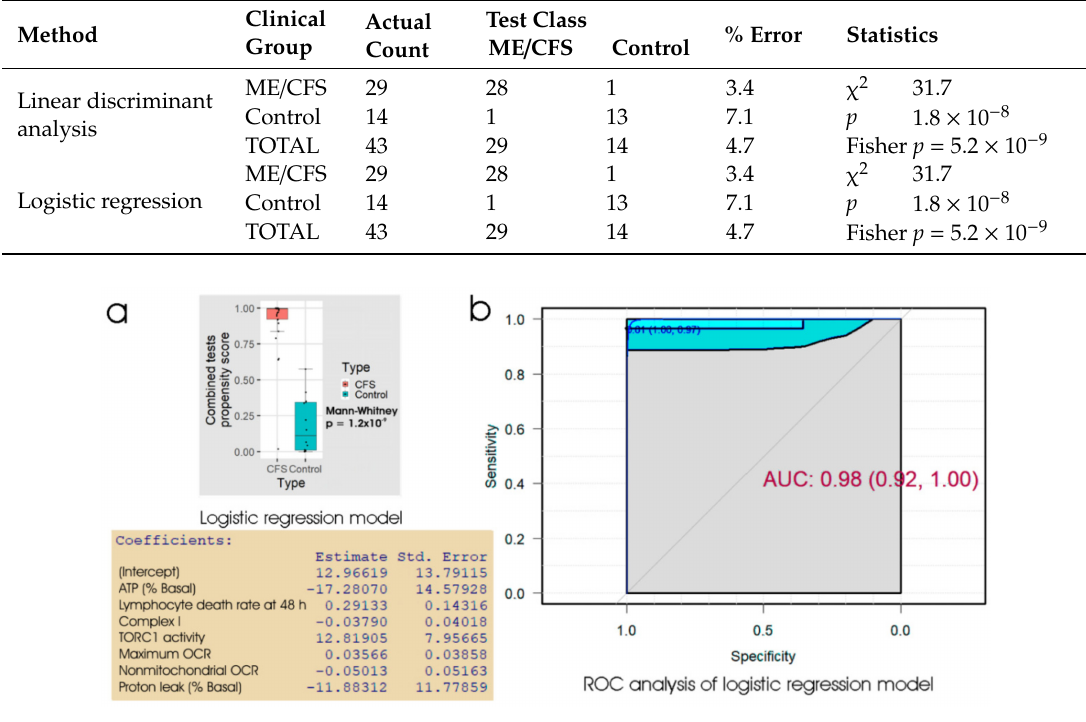
Figure 6. Logistic regression and ROC analysis of combined tests for lymphocyte death in culture, lymphoblast respiration and lymphoblast TORC1 activity. ( a ) Box plot showing the distribution of